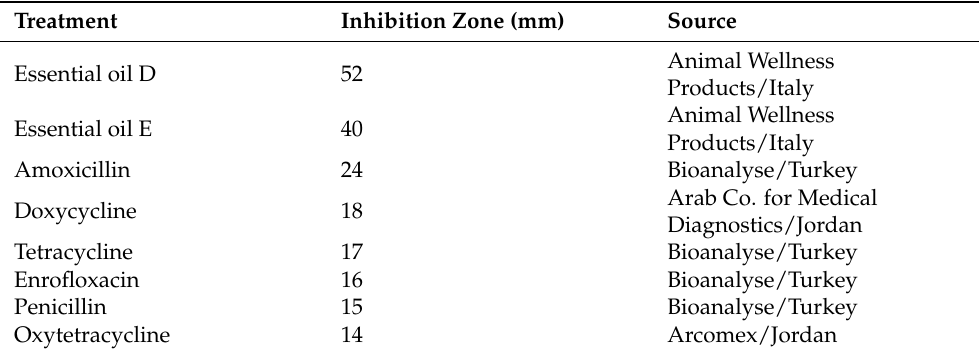
Table 1. Growth inhibition zones of different treatments against C. perfringens according to disk diffusion assay.